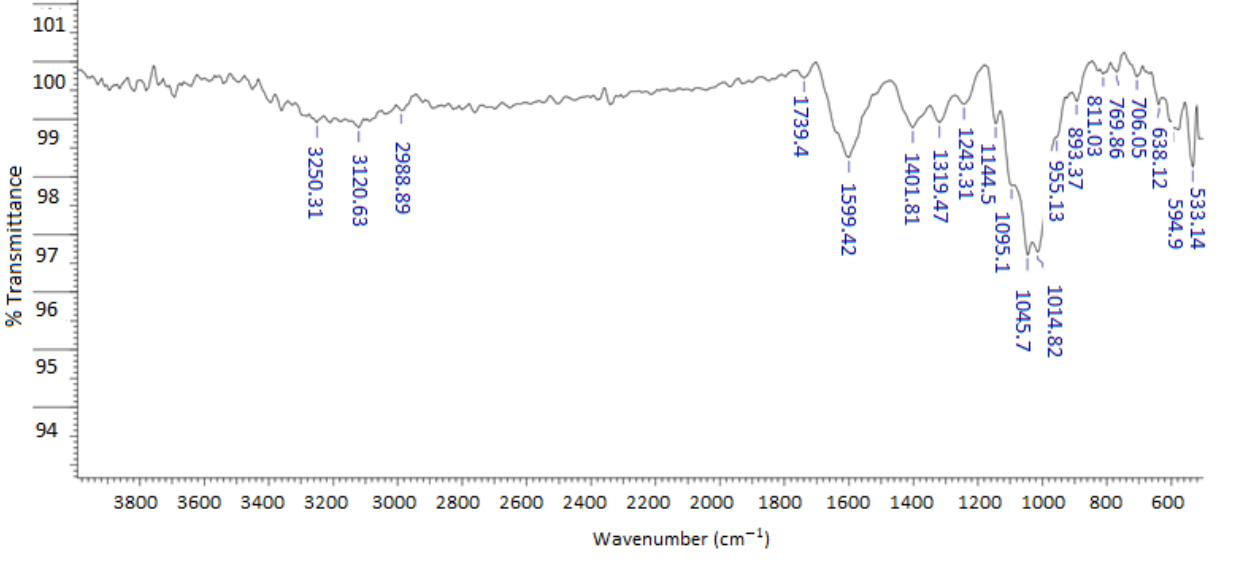
Figure 1. FTIR spectra of powdered mucilage extracted from yellow pitahaya fruit peel.